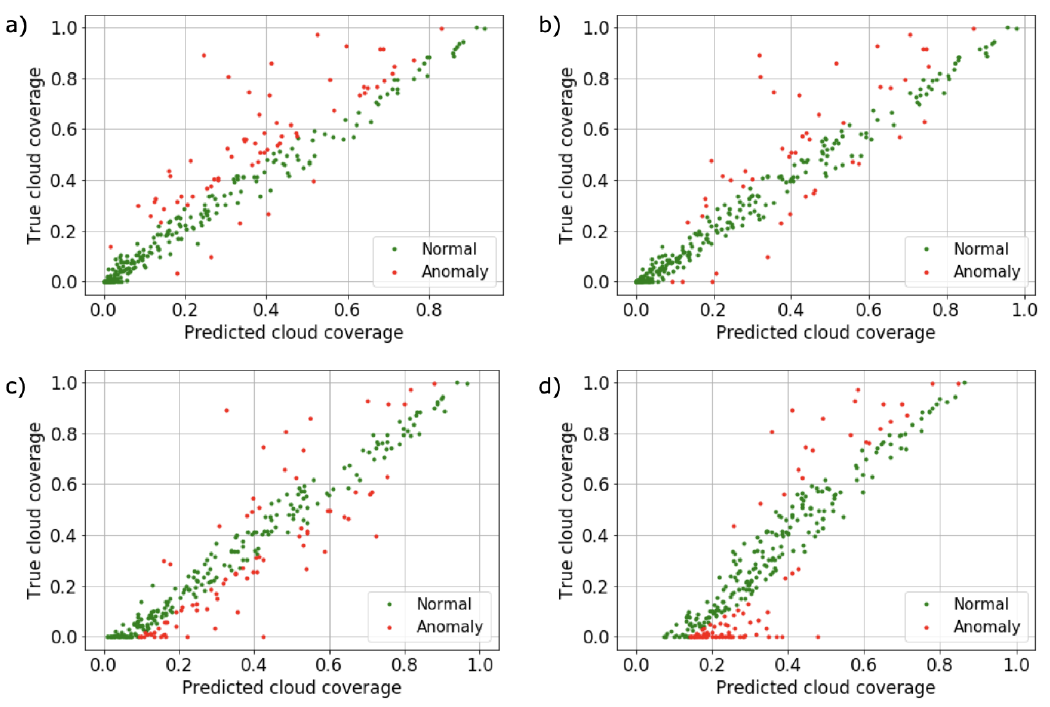
Figure 14. Cloud coverage prediction error depending on CNN models with anomaly points for error distances larger than 1 σ . ( a ) NU-Net (proposed) without patch decomposition, ( b ) RS-Net (Jeppesen, 2019) without patch decomposition, ( c ) NU-Net (proposed) with 16 × 16 patch decomposition, and ( d ) L-Unet (Zhang, 2019) with 16 × 16 patch decomposition.